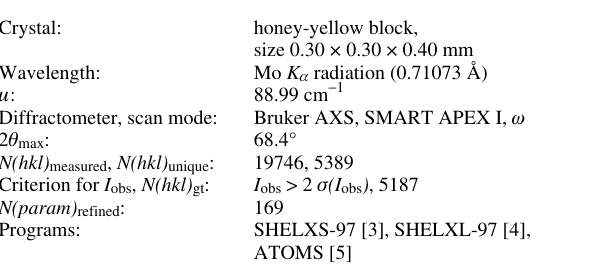
Table 1. Data collection and handling.